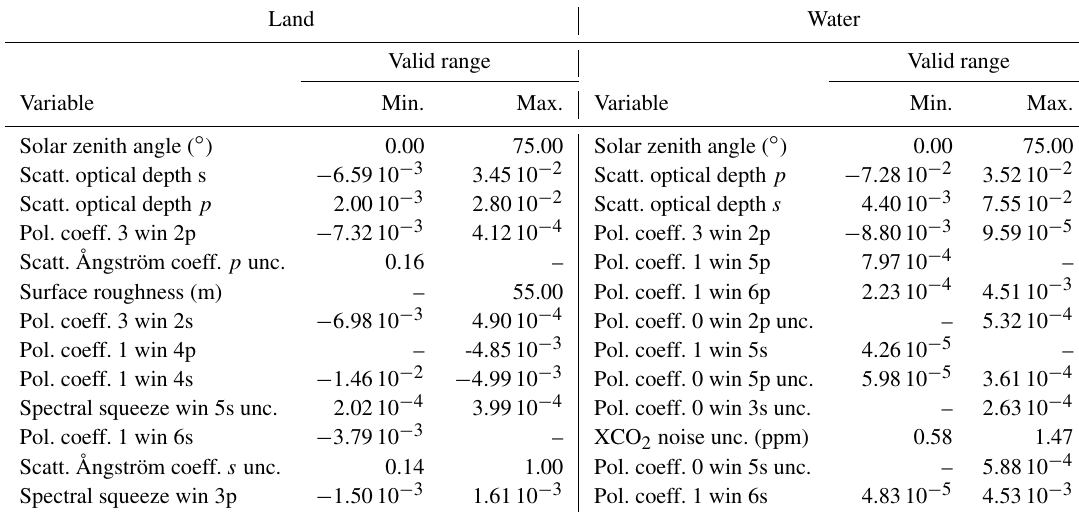
Table A2. XCH 4 filter variables and limits for GOSAT. “–” means that no limit is applied. Except for the solar zenith angle limits, the variables are ordered by their relevance, i.e. by the number of data filtered